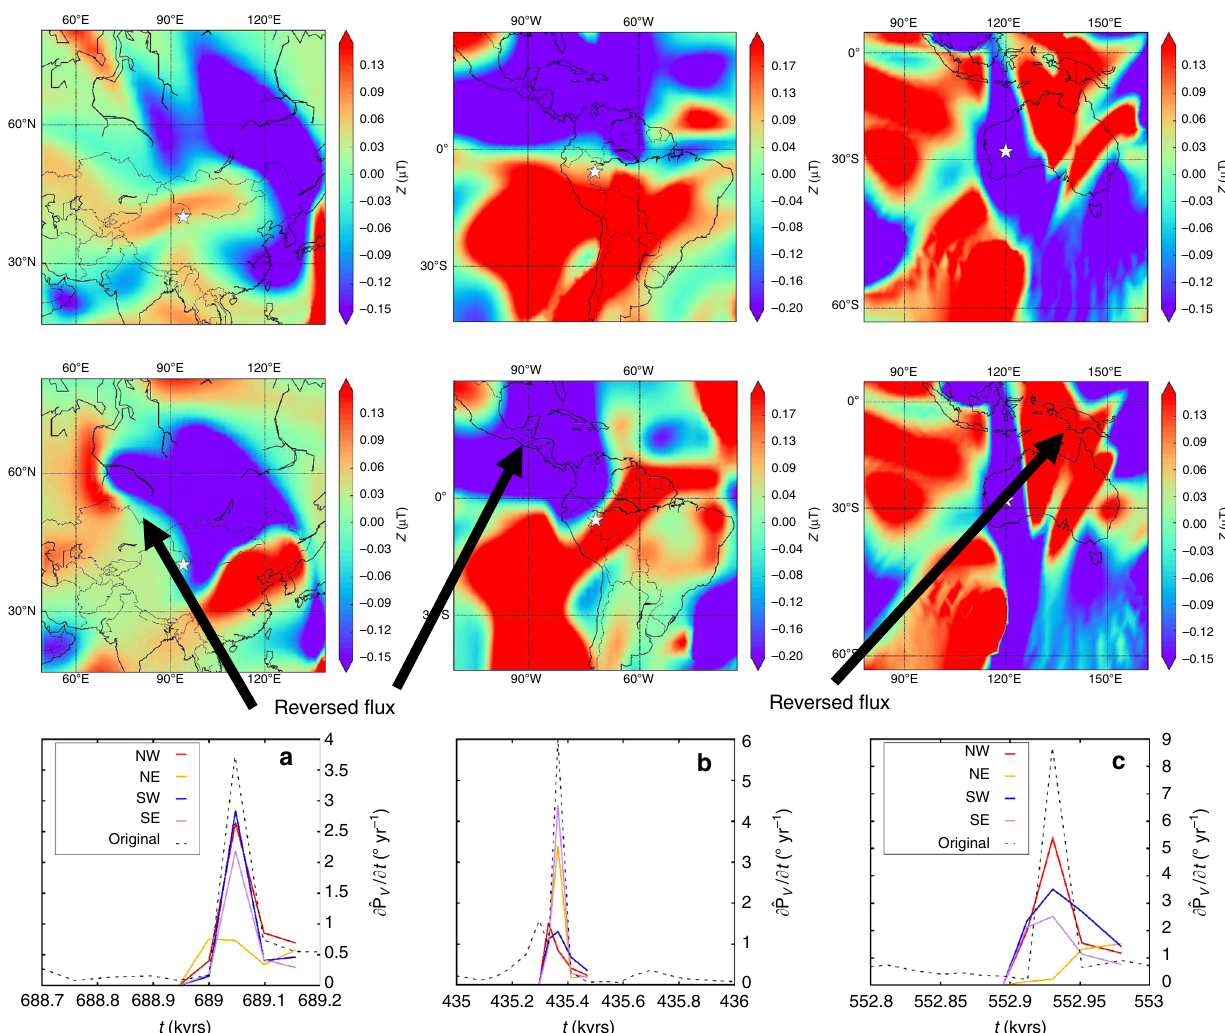
Fig. 6 Contributions of CMB fi eld features to rates of directional change at Earth ’ s surface. The three columns show extreme changes arising in the northern hemisphere (left), equatorial region (centre) and southern hemisphere (right) in simulations with E = 5 × 10 − 4 , Ra = 400, Pm = 5, Rm = 257 ( a ); E = 5 × 10 − 4 , Ra = 250, Pm = 10, Rm = 386 ( b ); E = 5 × 10 − 4 , Ra = 350, Pm = 10, Rm = 450 ( c ). Rows show local Mercator projections of the radial CMB fi eld just before (top) and during (middle) an extreme directional change located at the star. The bottom row shows the rate of VGP change, ∂ ^ P V = ∂ t , at the location of the star based on the original CMB fi eld and four modi fi ed versions of the CMB fi eld wherein the fi eld in the denoted quadrant has been halved in amplitude. In this projection the four quadrants denoted northwest (NW), northeast (NE), southwest (SW) and southeast (SE) tessellate the regions shown in the fi rst two rows and share a common vertex centred at the